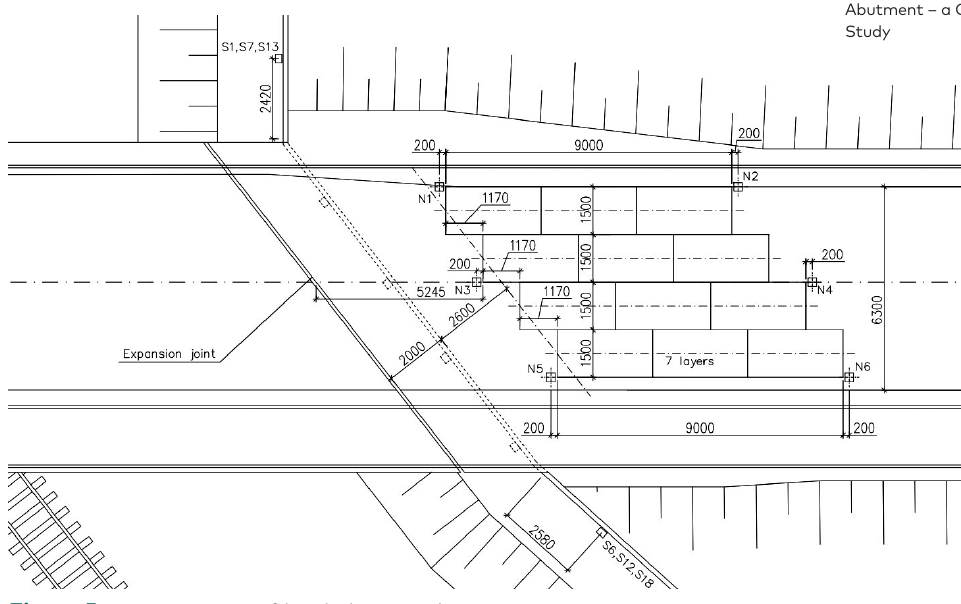
Figure 5. Arrangement of load plates – plan view